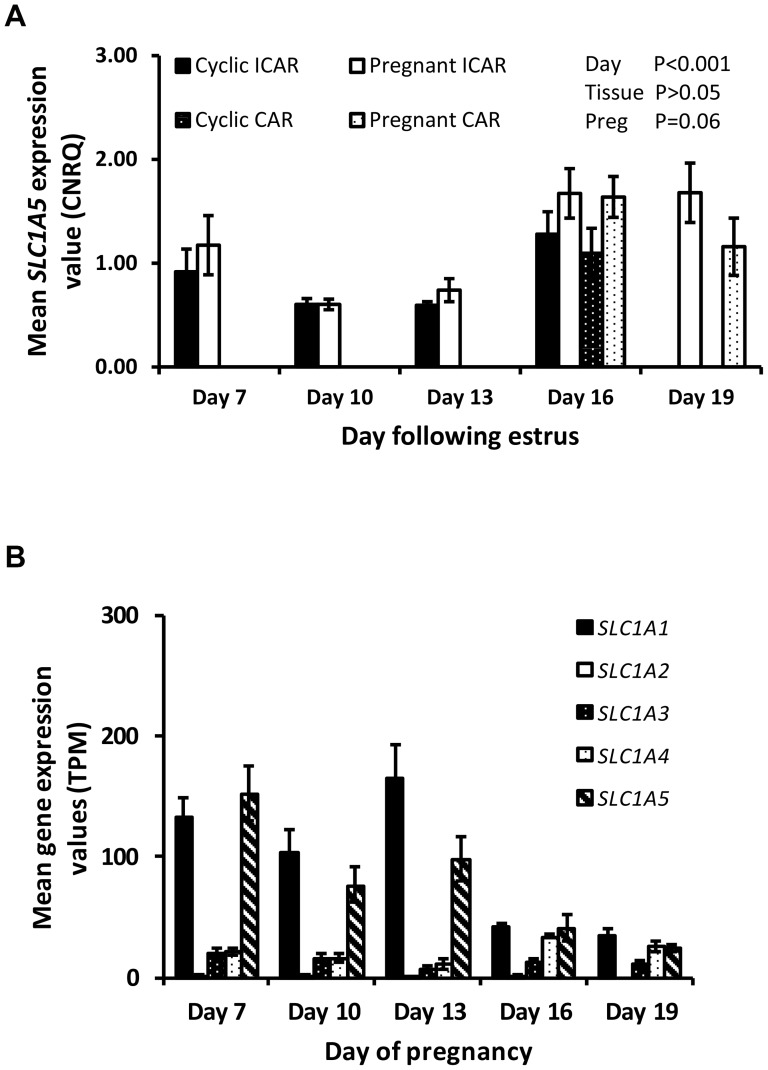
Gene expression values in the endometrium for acidic amino acid transporters as determined by qRT-PCR analysis.Data are displayed as mean calibrated, normalized, relative expression values in arbitrary units (CNRQ ± SEM) in the intercaruncular region of the endometrium from cyclic (solid bars) and pregnant (open bars) heifers and caruncular regions of cyclic (black bars white stipple) and pregnant heifers (while bars black stipple) (n = 5 per treatment per time-point). (A) SLC1A5CNRQ expression with a significant effect of day (P<0.001) and pregnancy status (P = 0.06). (B) Gene expression values for acidic amino acid transporters in the bovine embryo during distinct developmental stages. Values were determined by RNA sequencing and are given as mean transcripts per million (TPM ± SEM) with n = 5 per time-point. A significant effect of stage of embryo development was observed for all genes (P<0.05).